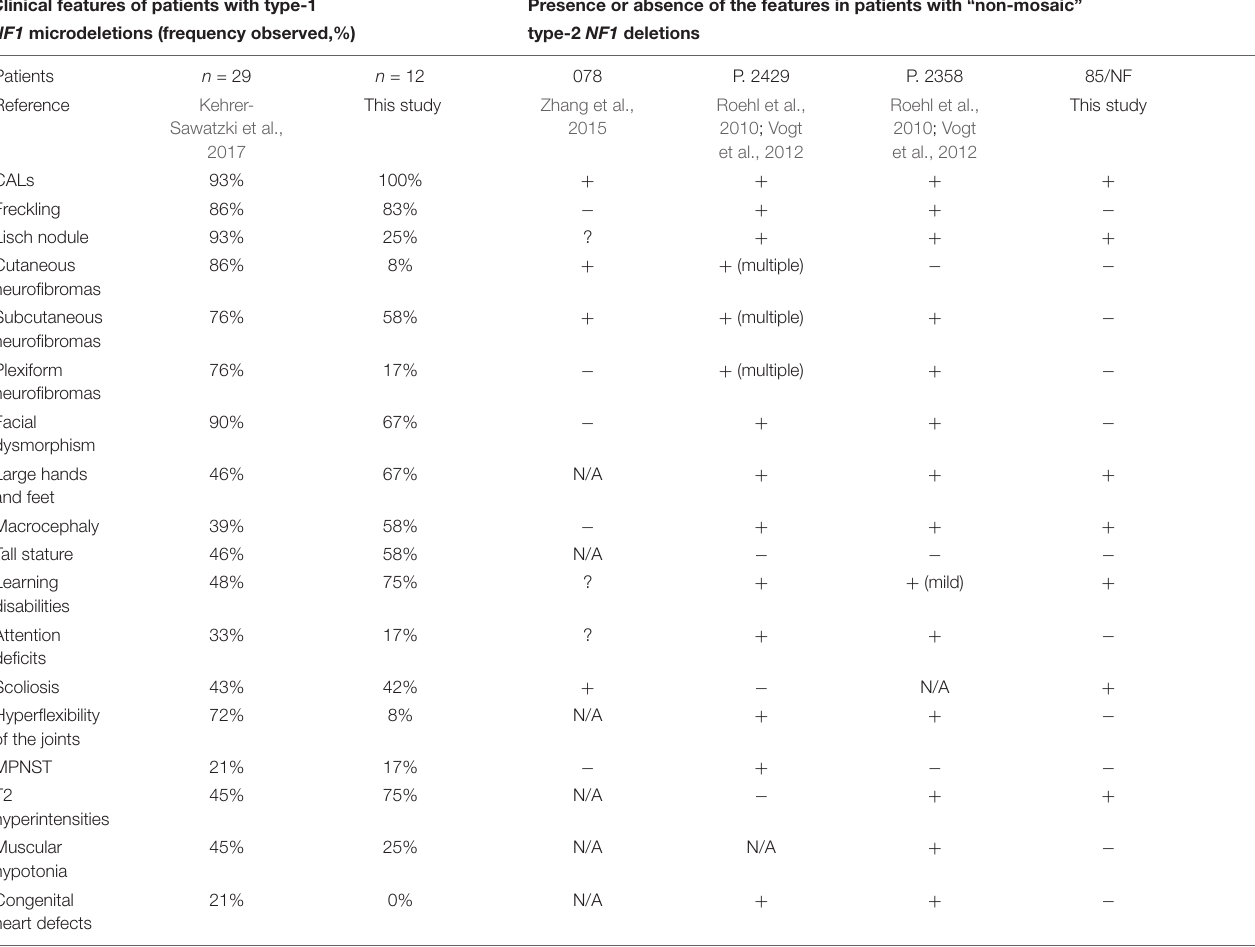
TABLE 3 | Clinical features of patients with type-2 NF1 microdeletions. Clinical features of patients with type-1 Presence or absence of the features in patients with